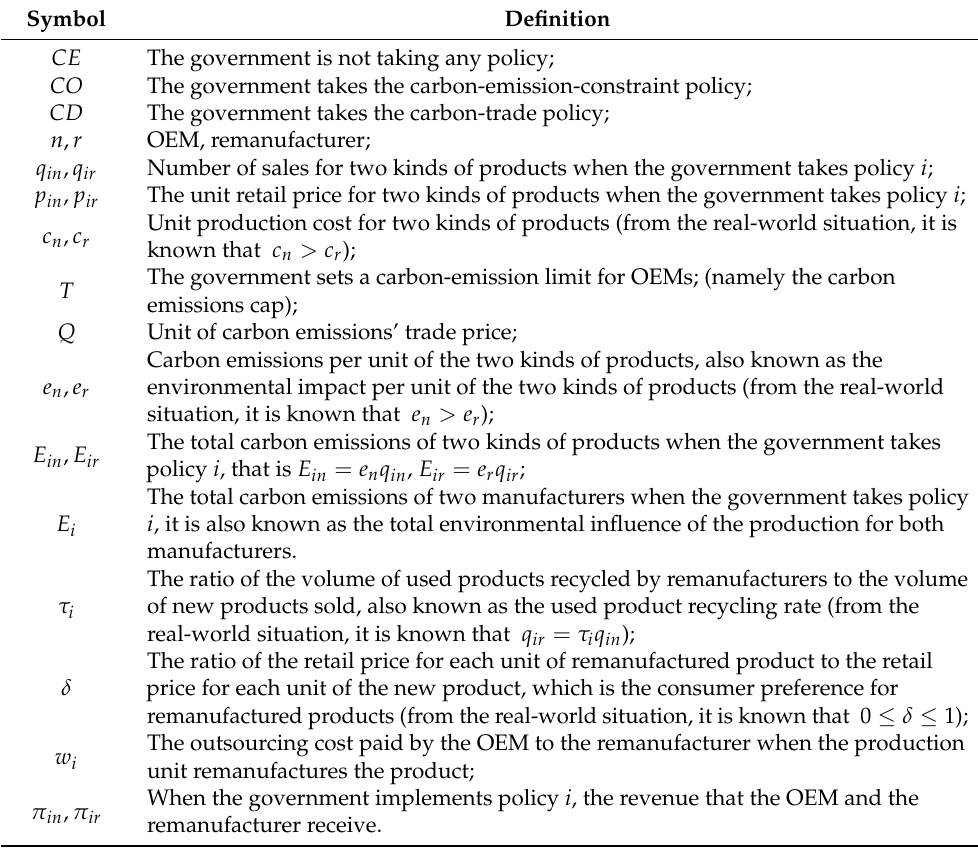
Table 1. Definition of